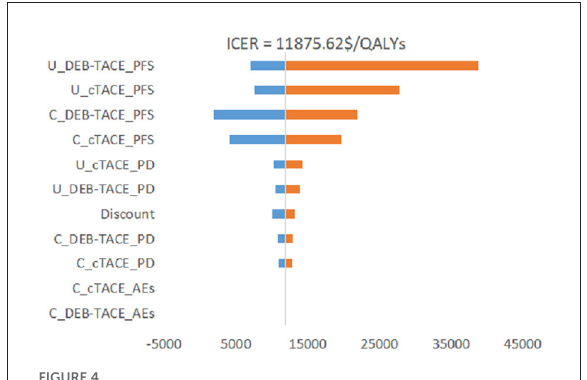
FIGURE4 Tornado chart of one-way sensitivity analysis.